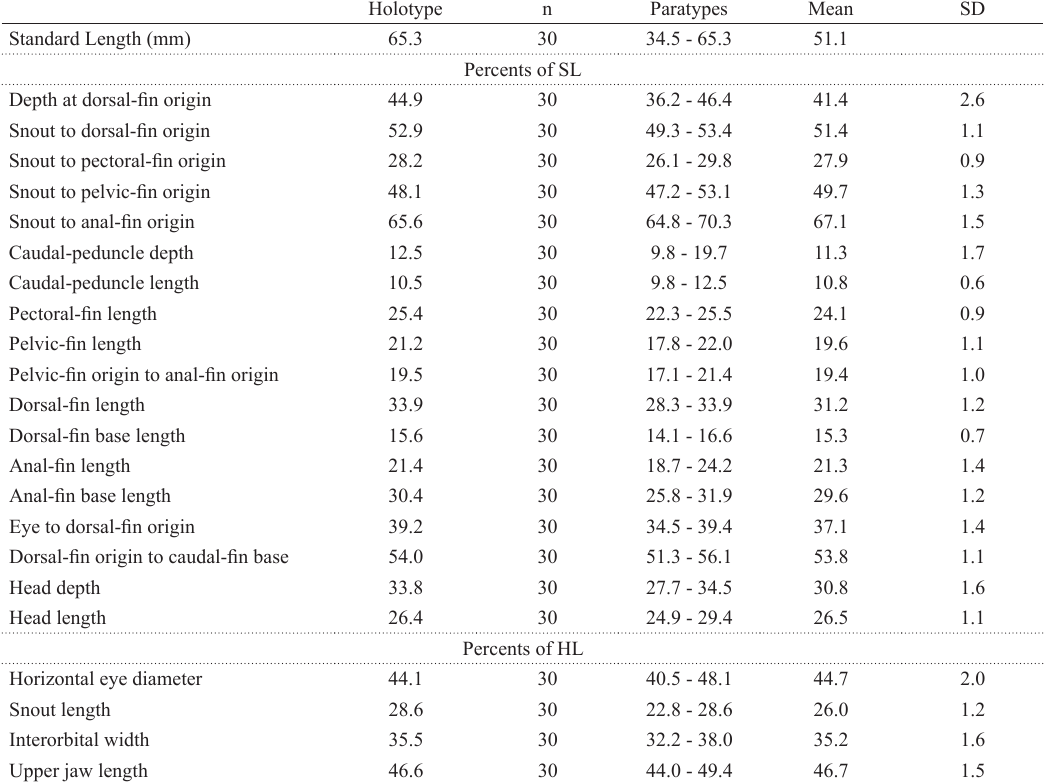
Table 1. Morphometric data of Moenkhausia mutum . Range of paratypes includes the holotype. SD = Standard deviation, n = number of